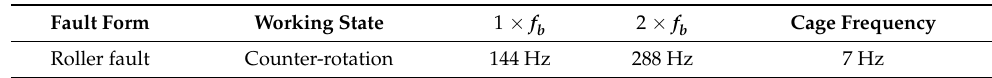
Table 5. The FCF of the roller fault.